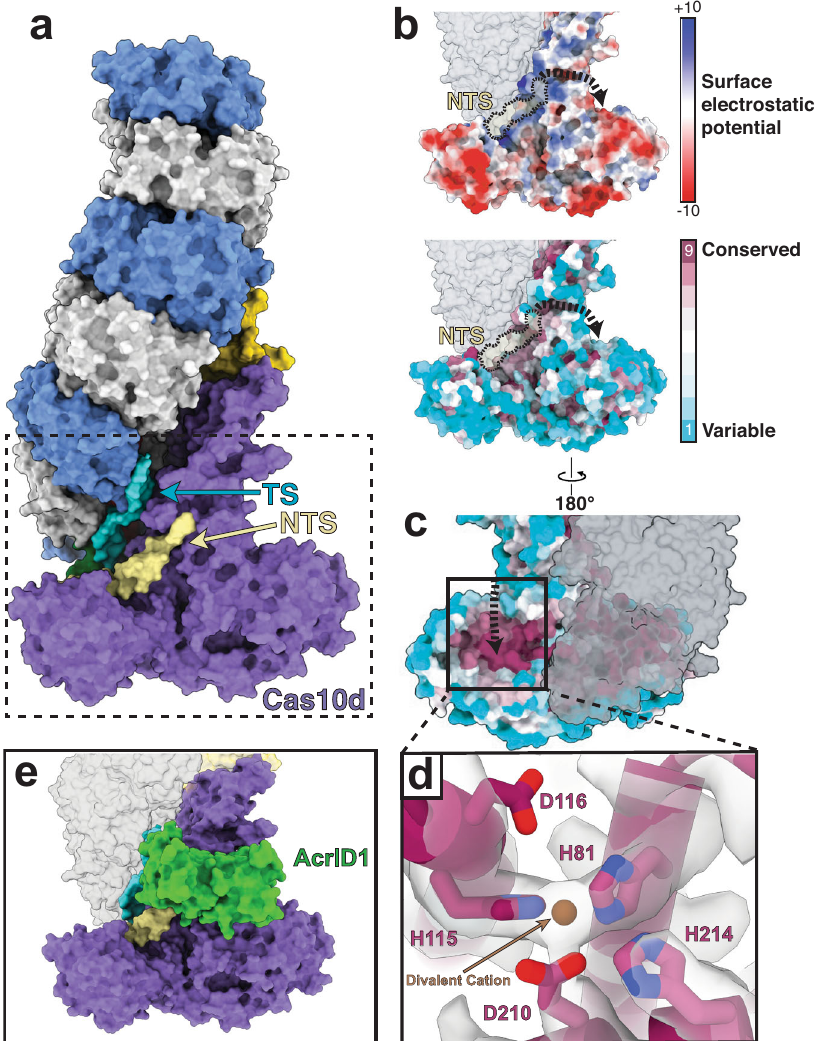
Fig. 3 R-loop formation directs the non-target strand toward the HD domain. a R-loop formation begins with unwinding of the PAM-proximal duplex with the target strand (cyan) traveling up along the Cas7 fi lament and the non-target strand traveling across the front of Cas10d. b Electrostatic surface potential and conservation scores appear correlated, where positive patches are more highly conserved and coordinate the non-target strand towards the active site on the back of Cas10d. Dashed line (black) represents the putative path of the NTS towards the active site of Cas10d, where nicking occurs. c Active site of Cas10d is highly conserved relative to the rest of the Cas10d surface. d H115, D116, H81, D210, and H214 form the active site of Cas10d to cleave the non-target strand. These four residues are highly conserved and likely coordinate a divalent cation. e Crystal structure of AcrID1 (PDB: 6thh, (Manav et al. 28 )) overlayed onto the Cas10d subunit of our cryo-EM structure. AcrID1 prevents dsDNA R-loop formation by binding to the face of Cas10d, obstructing the path of the non-target strand towards the HD site. Subunits are colored as in Fig.